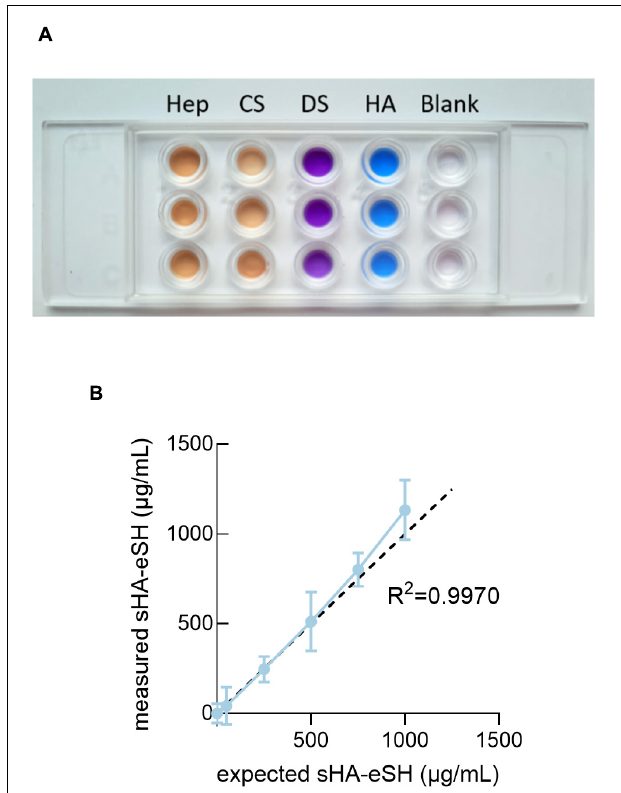
Figure 3 | Detection of GAGs in PEG hydrogels. (A) PEG hydrogels were prepared with 1 mg/mL end-thiolated GAGs [heparin (Hep), chondroitin sulfate (CS), dermatan sulfate (DS) and hyaluronan (HA)] and stained with Stains-All after incubation in borate buffer for 24 h. Stained gels reveal a detection of GAGs with distinct colors. Blank samples were prepared with water and appeared colorless. (B) Quantification of sHA-eSH in a carbazole-based assay. PEG hydrogels were functionalized with 0.5 mM linRGD and varying amounts of sHA-eSH (0–1 mg/mL). Measured HA-eSH concentrations are plotted against expected concentrations. Hydrogels were swollen in PBS > 20 h and lyophilized, before performing the assay; mean and standard deviation of triplicates/quadruplicates are presented.